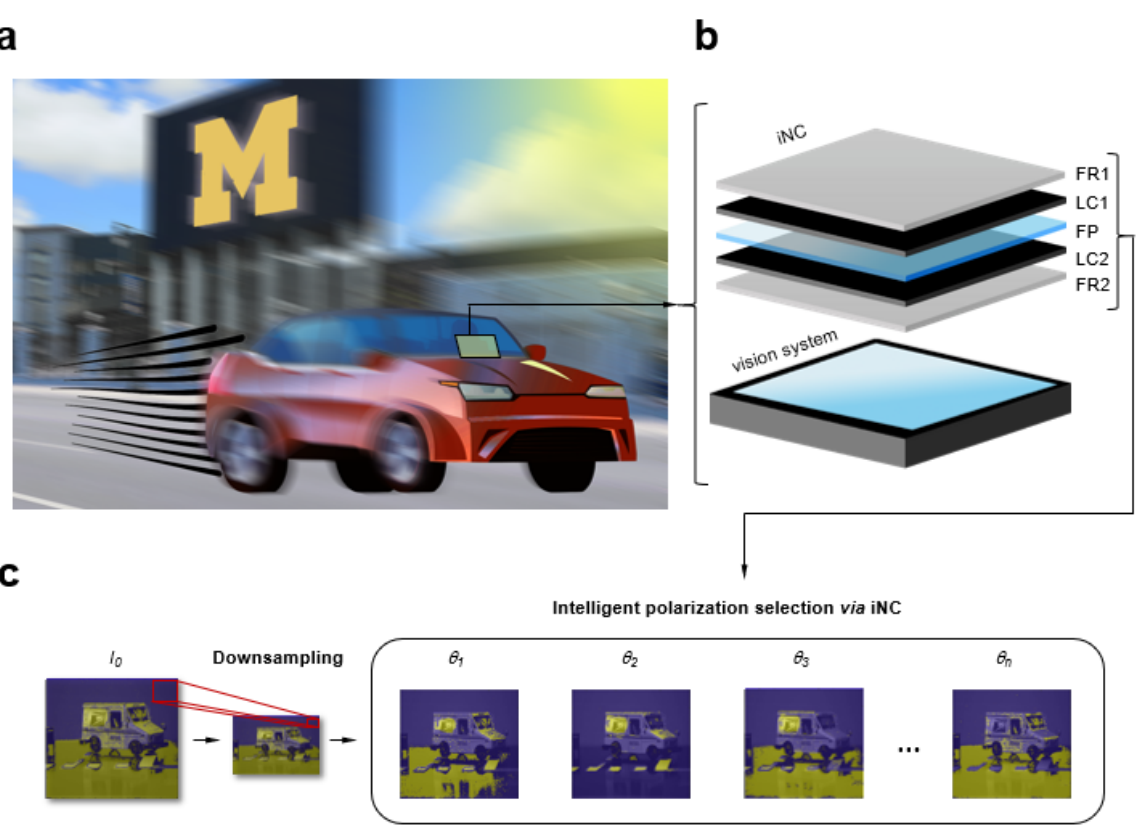
Figure 1. Intelligent fusion imaging photonics for real-time lighting obstructions. ( a ) Conceptual schematic of dynamic detection in challenging lighting conditions. Rapid increase and decrease in contrast and saturation obscures objects, resulting in loss of visibility. ( b ) Conceptual schematic of experimental setup consisting of iNC incorporated on top of a vision system (CMOS camera). FR1, fixed retarder; LC1, liquid crystal retarder; FP, fixed polarizer; LC2, liquid crystal retarder; FR2, fixed retarder. ( c ) Intelligent polarization selection process by iNC: Voltage to the iNC was modulated. Images were downsampled and segmented based on optimal polarization by analyzing each pixel such that the relation of the intensity of the pixel to the segmentation was not in the spatial domain but in the polarization